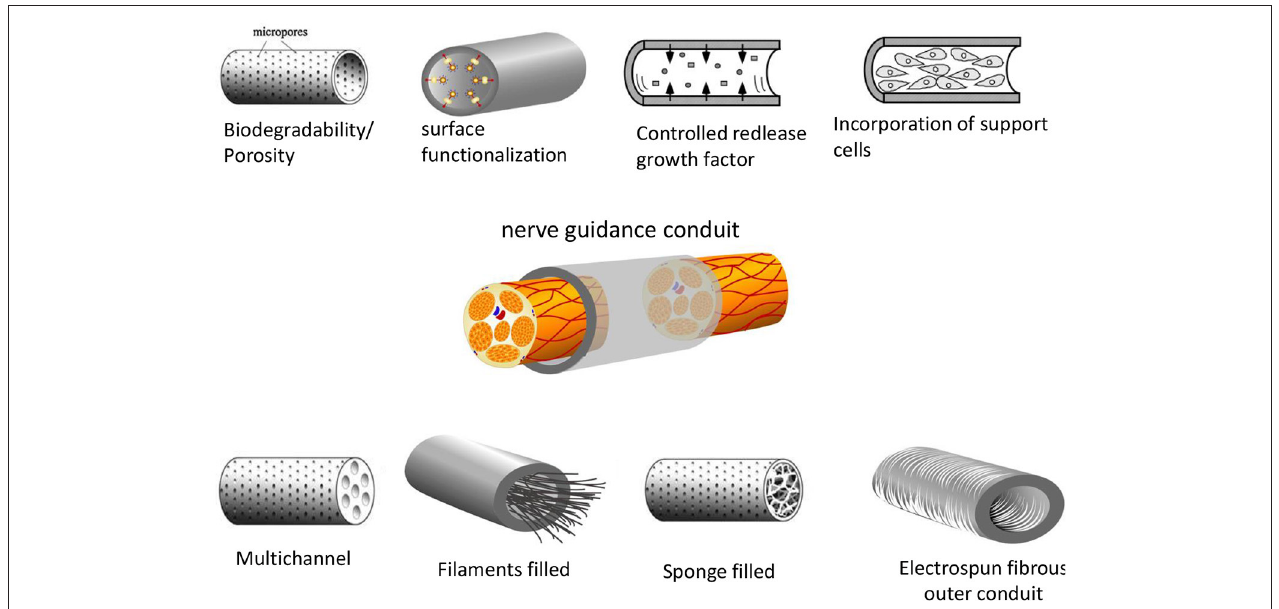
FIGURE 6 | Different designs of nerve guidance conduits (NGCs). The basic design parameters include: a biodegradable and porous channel wall, a biofunctionalized wall surface including adhesive and growth factors, intraluminal structures to mimic the structure of nerve fascicles, intraluminal guidance structures (filaments, sponge or hydrogel-like) or wall microstructures to support cell migration and axonal growth. Support cells can also be incorporated to the NGCs ( Daly et al., 2012) Copyright 2012, The Royal